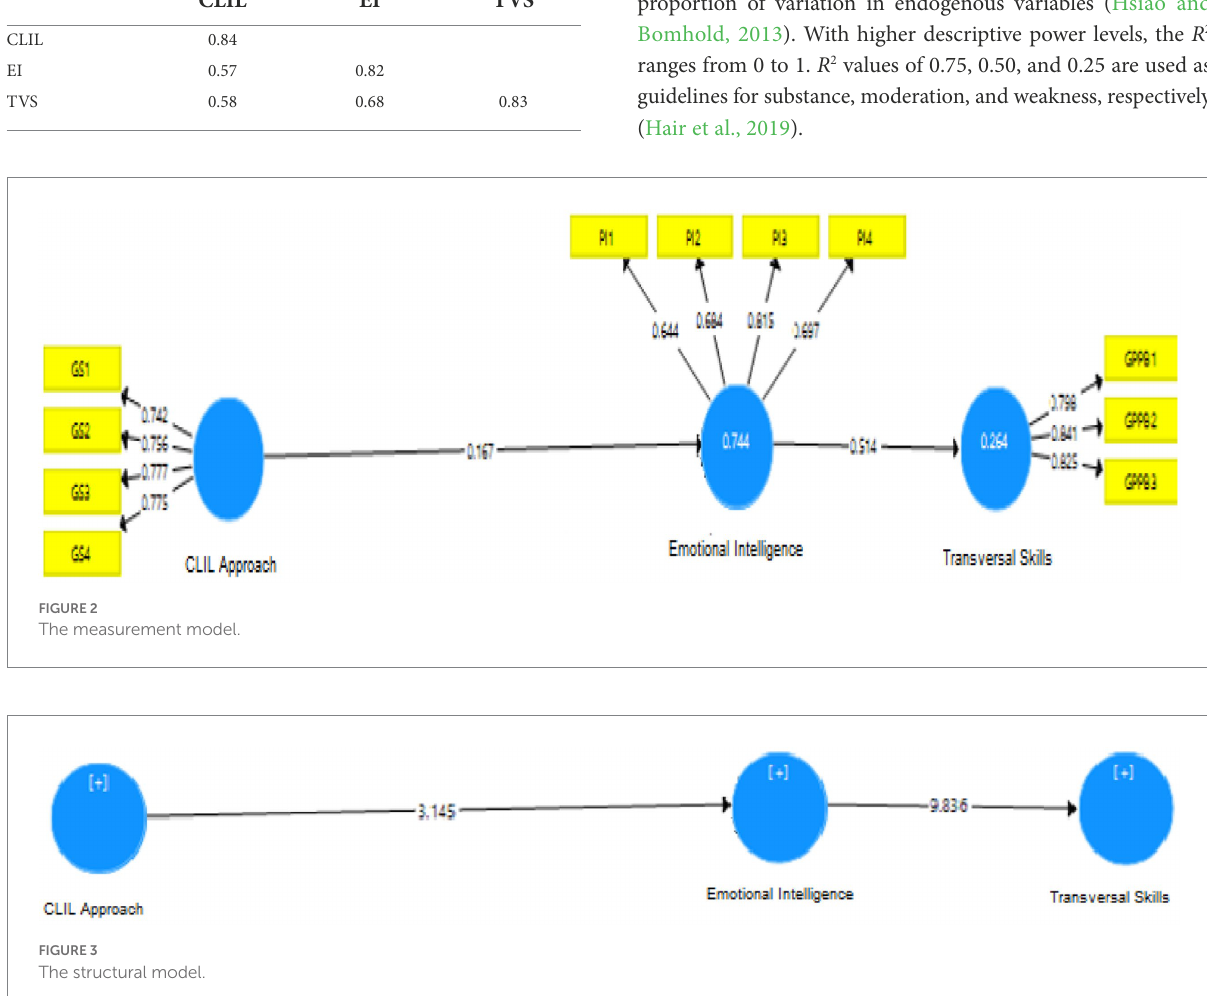
FIGURE 3 The structural model.